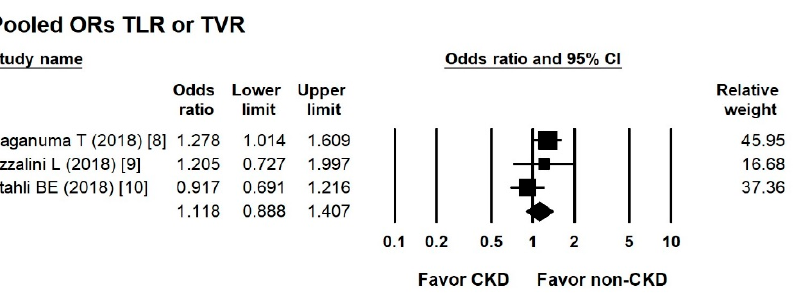
Figure 5. Forest plots of the incidence of target lesion revascularization and target vessel revascularization in the CKD and non-CKD groups from four studies.